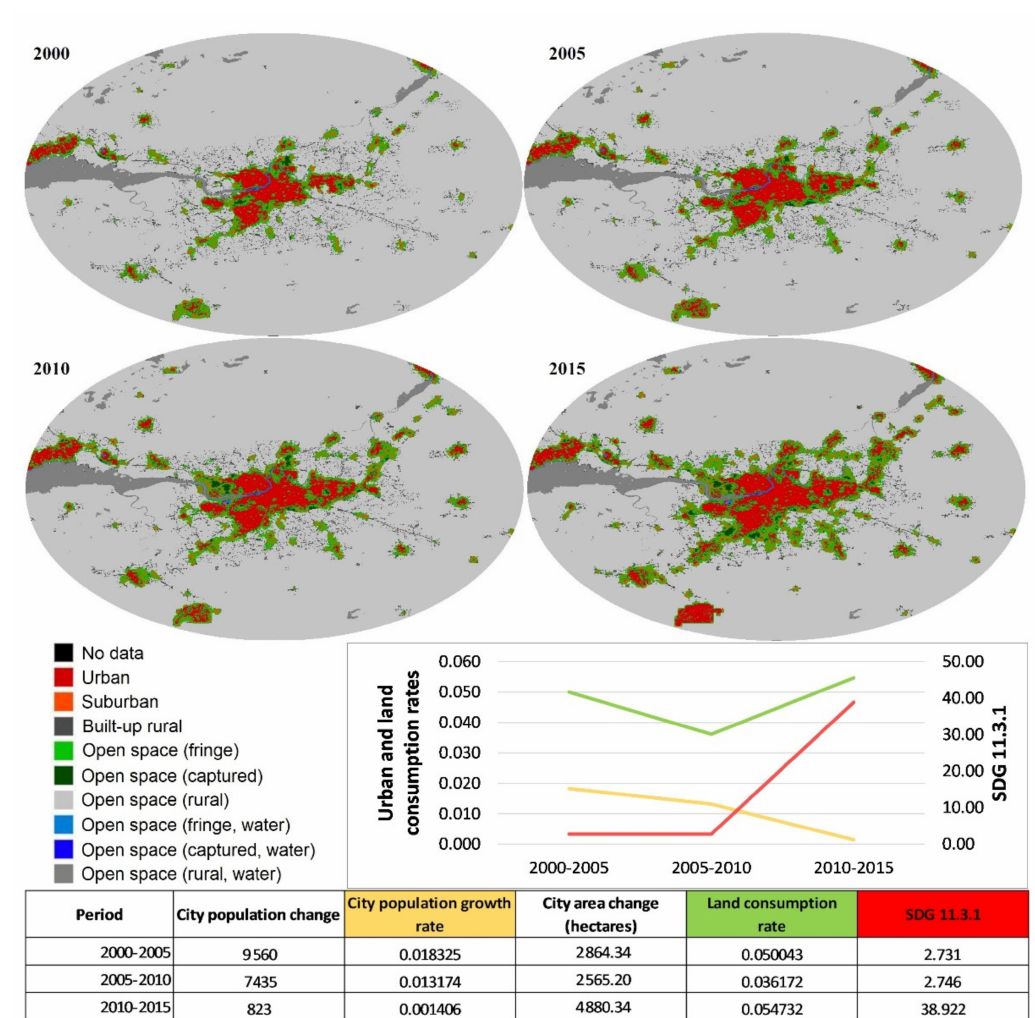
Figure 7. The evolution of Limerick’s urban expansion maps. The grey circle around the map of Limerick City indicates the buffer that needs to be applied for computational reasons (threshold of estimated area). The trends of population and land use changes are also analytically presented in a table and a diagram form, together with the results of the estimated indicator